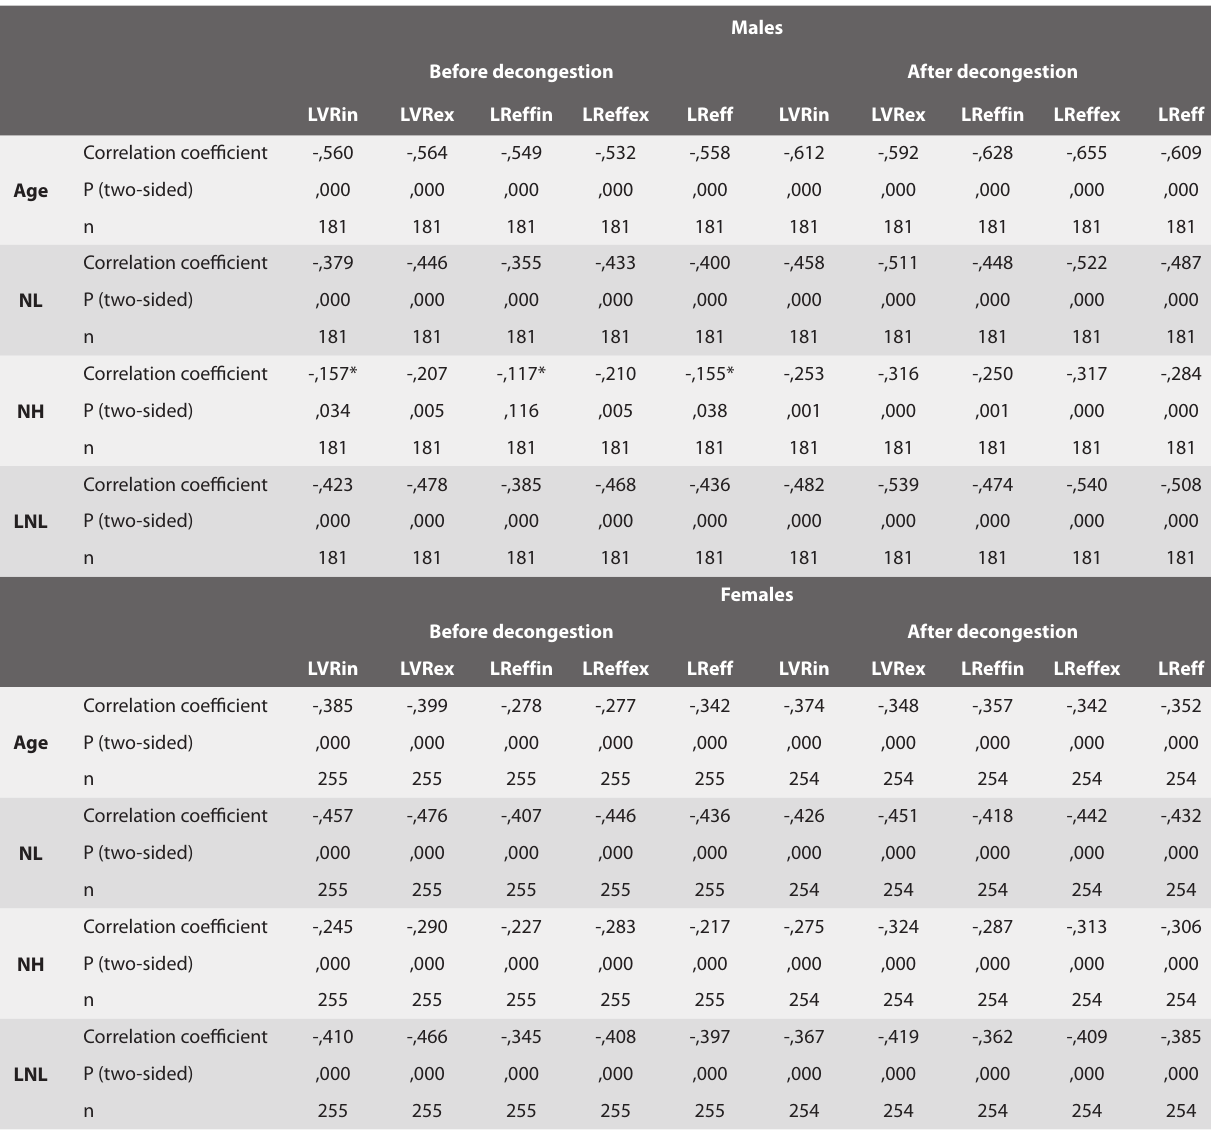
Table 4. Pearson’s correlations among age, selected anthropometric parameters, and